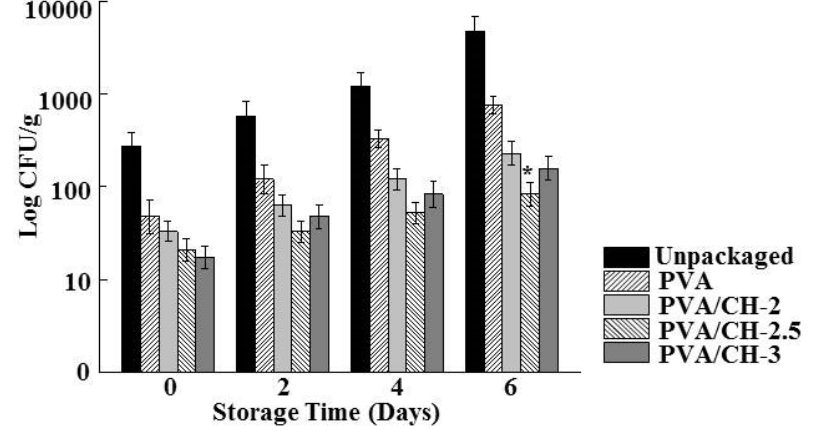
Figure 6. Evolution of mold and yeast counts of unpackaged and packaged strawberries with different PVA/CH films during storage times.